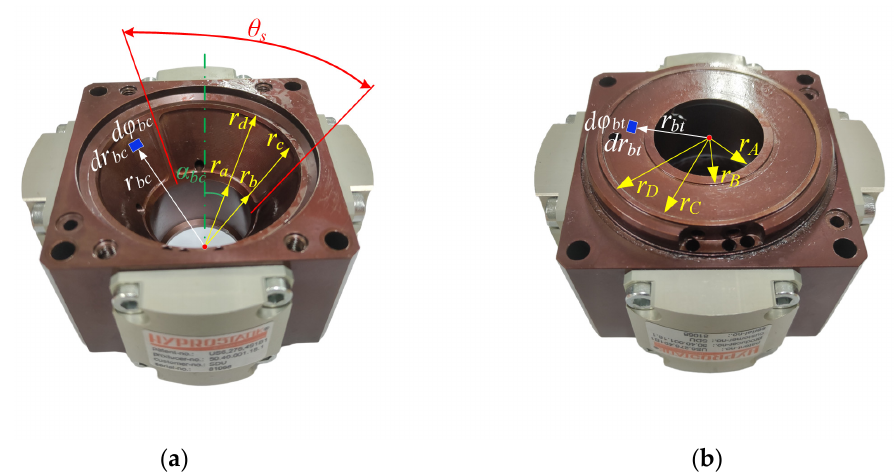
Figure 4. The front hydrostatic bearing. ( a ) the tapered bearing. ( b ) the thrust bearing.